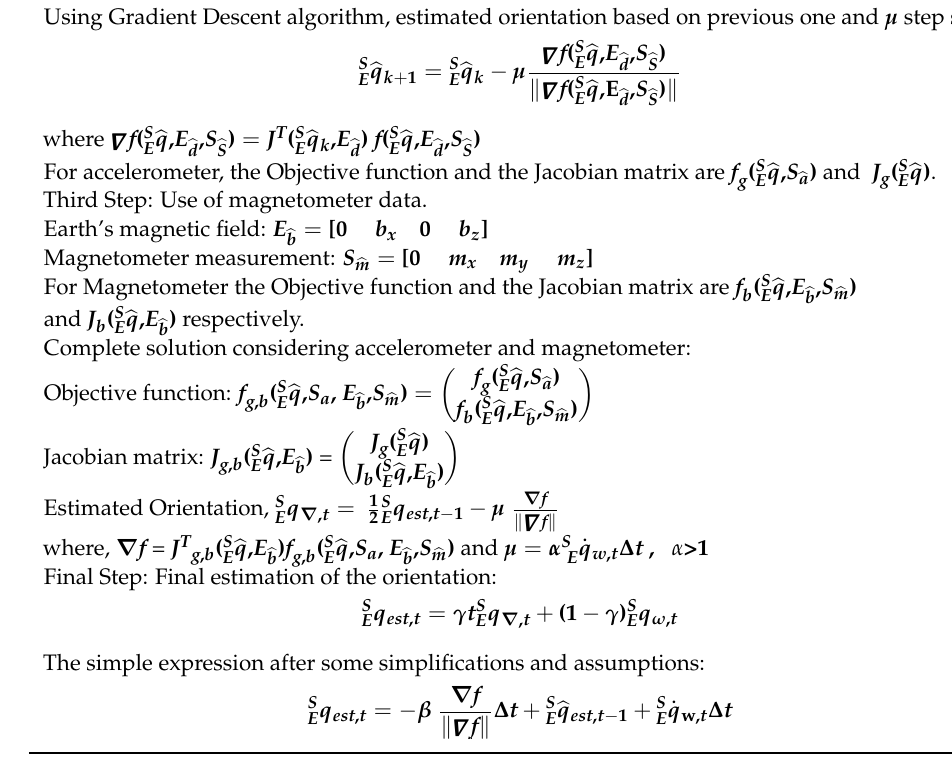
Algorithm 2 Madgwick Filter [32]